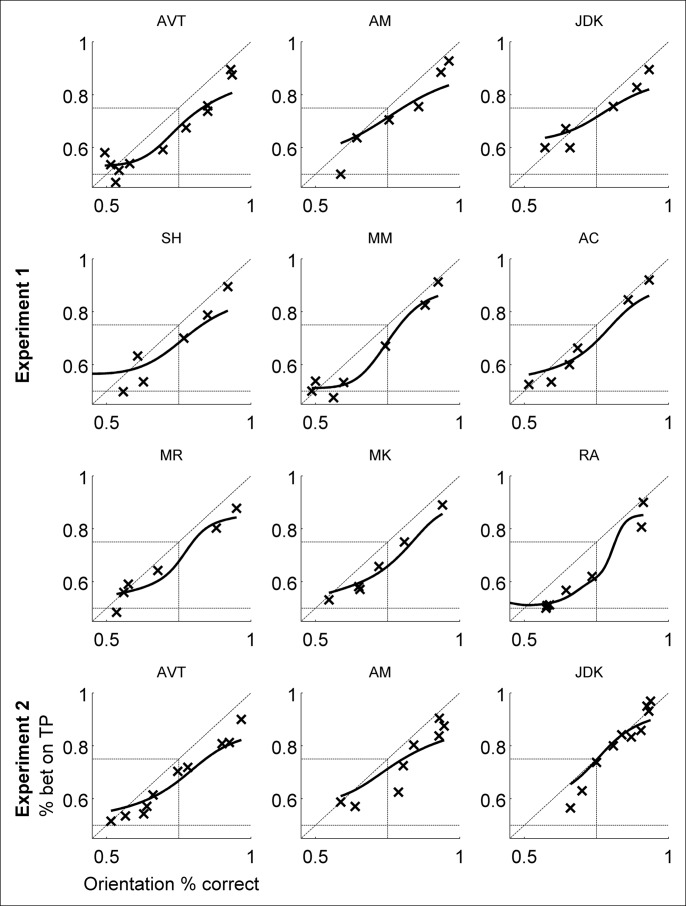
Individual subjects’ data for percent betting on target-present (TP) interval as a function of orientation discrimination percent correct.Individual subjects’ data closely resembles grouped data: all subjects exhibited Performance > Awareness, but no subjects exhibited Performance without Awareness. The same three subjects participated in both Experiments 1 and 2.